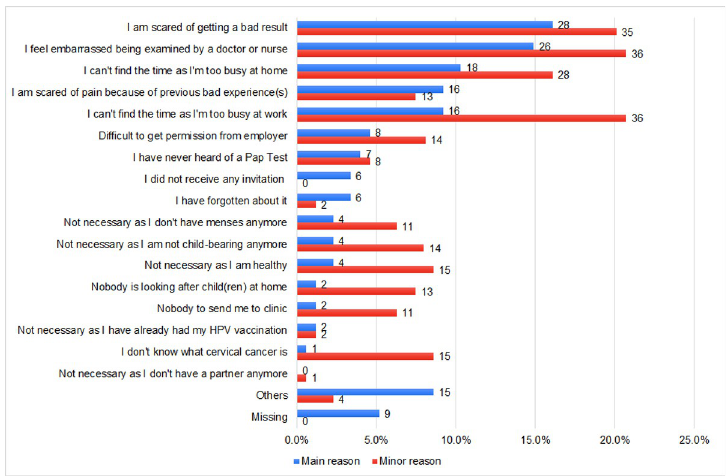
Fig 2. Responses on their major and minor reasons for not attending cervical cancer screening, among non- attendees at JPSHC (Jan–Dec 2019). The x-axis indicates the percentage, and the number next to each bar indicates the actual number of